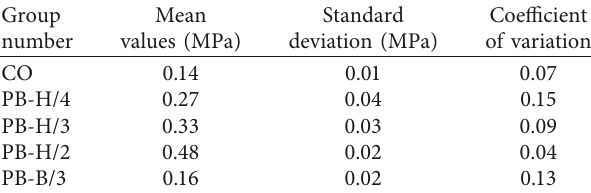
Table 1: Measured value of shear strength.